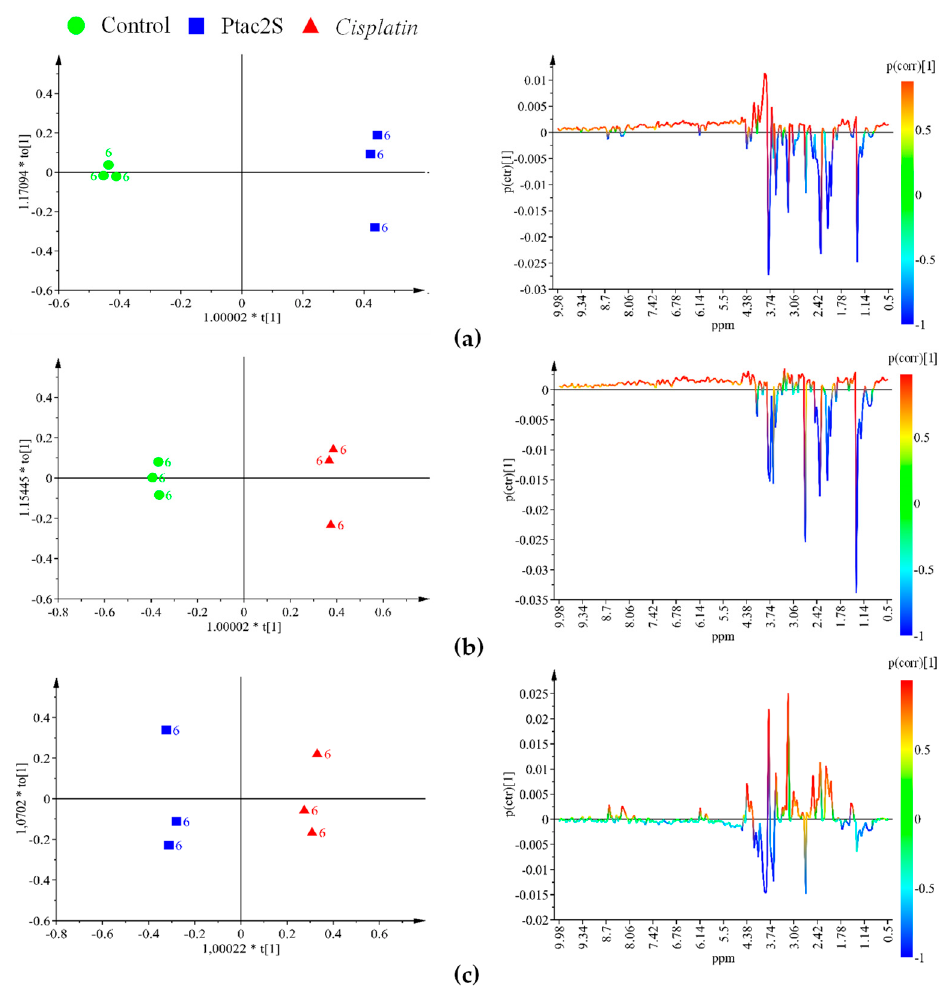
Figure 4. OPLS-DA score plot ( left panel) and corresponding coefficient plot ( right panel) of the 600 MHz 1 H-CPMG-NMR spectra (Pareto scaled) of SKOV-3 cells aqueous extracts obtained from different pairwise groups (controls, Ptac2S and cisplatin) at 6 h. ( a ) OPLS-DA t[1]/t[2] scores scatter plot (two components, 1 predictive + 1 orthogonal, give R 2 X = 0.911, R 2 Y = 0.999, Q 2 = 0.988). ( b ) OPLS-DA t[1]/t[2] scores scatter plot (two components, 1 predictive + 1 orthogonal give R 2 X = 0.886, R 2 Y = 0.999, Q 2 = 0.984). ( c ) OPLS-DA t[1]/t[2] scores scatter plot (two components, 1 predictive + 1 orthogonal give R 2 X = 0.875, R 2 Y = 0.995, Q 2 = 0.984).